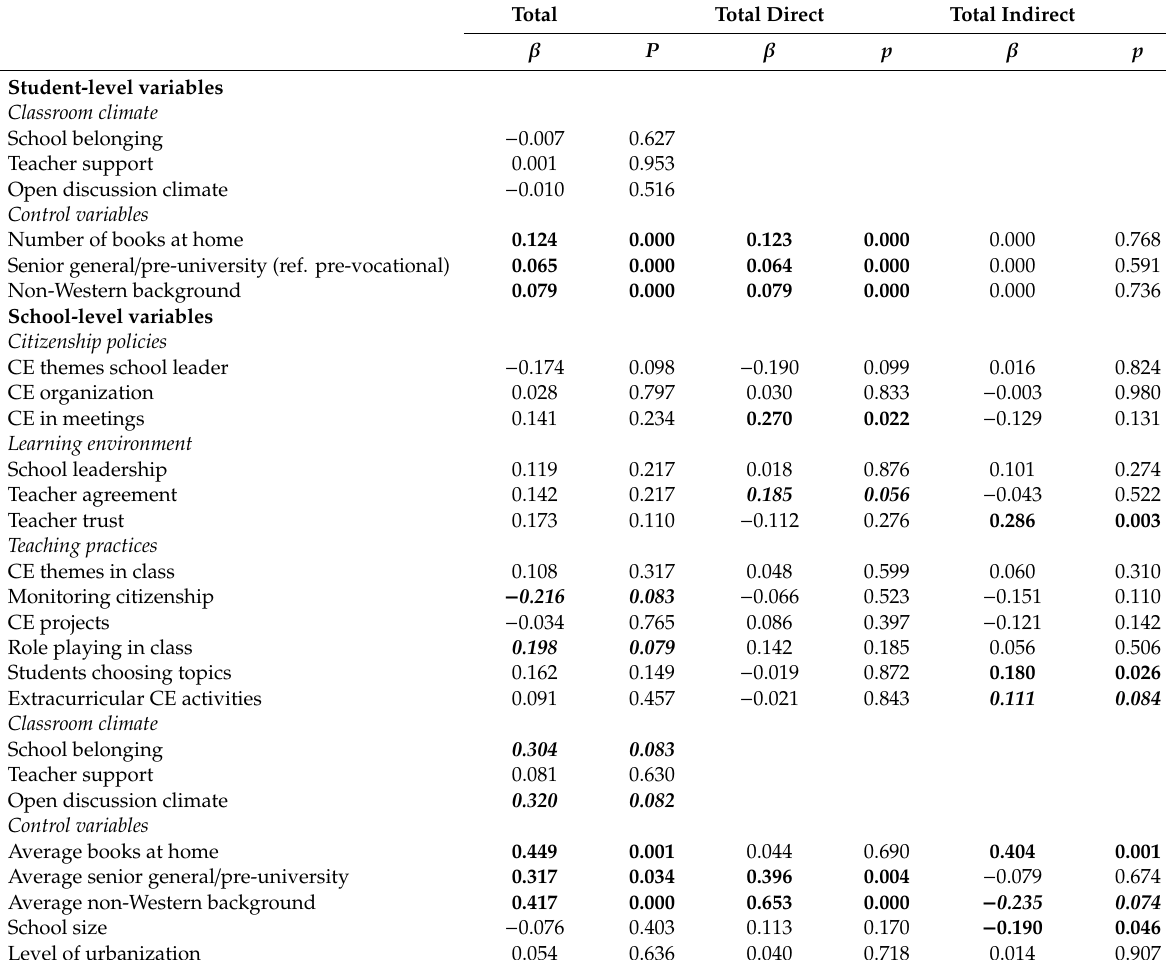
Table 4. Total, direct and indirect e ff ects on citizenship attitudes (standardized